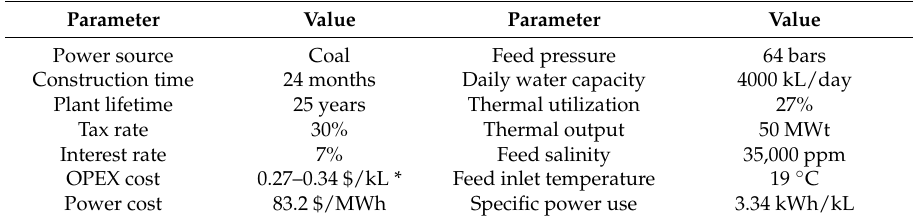
Table 2. The main variables employed in DEEP models.